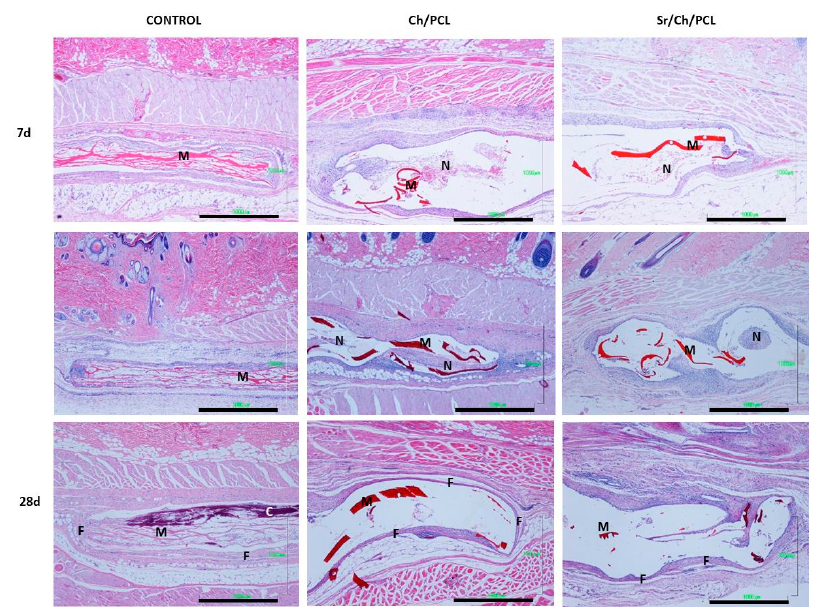
Figure 10. Micrographs of rat subcutaneous tissue responses to Control, Ch/PCL and Sr/Ch/PLC membranes after different implantation times (7, 14 and 28 days). M: membrane, N: necrotic tissue, F: fibrous tissue, C: calcification (H-E, 4 × , scale bar 1 mm). Ch: chitosan; PCL: poly( ε -caprolactone).